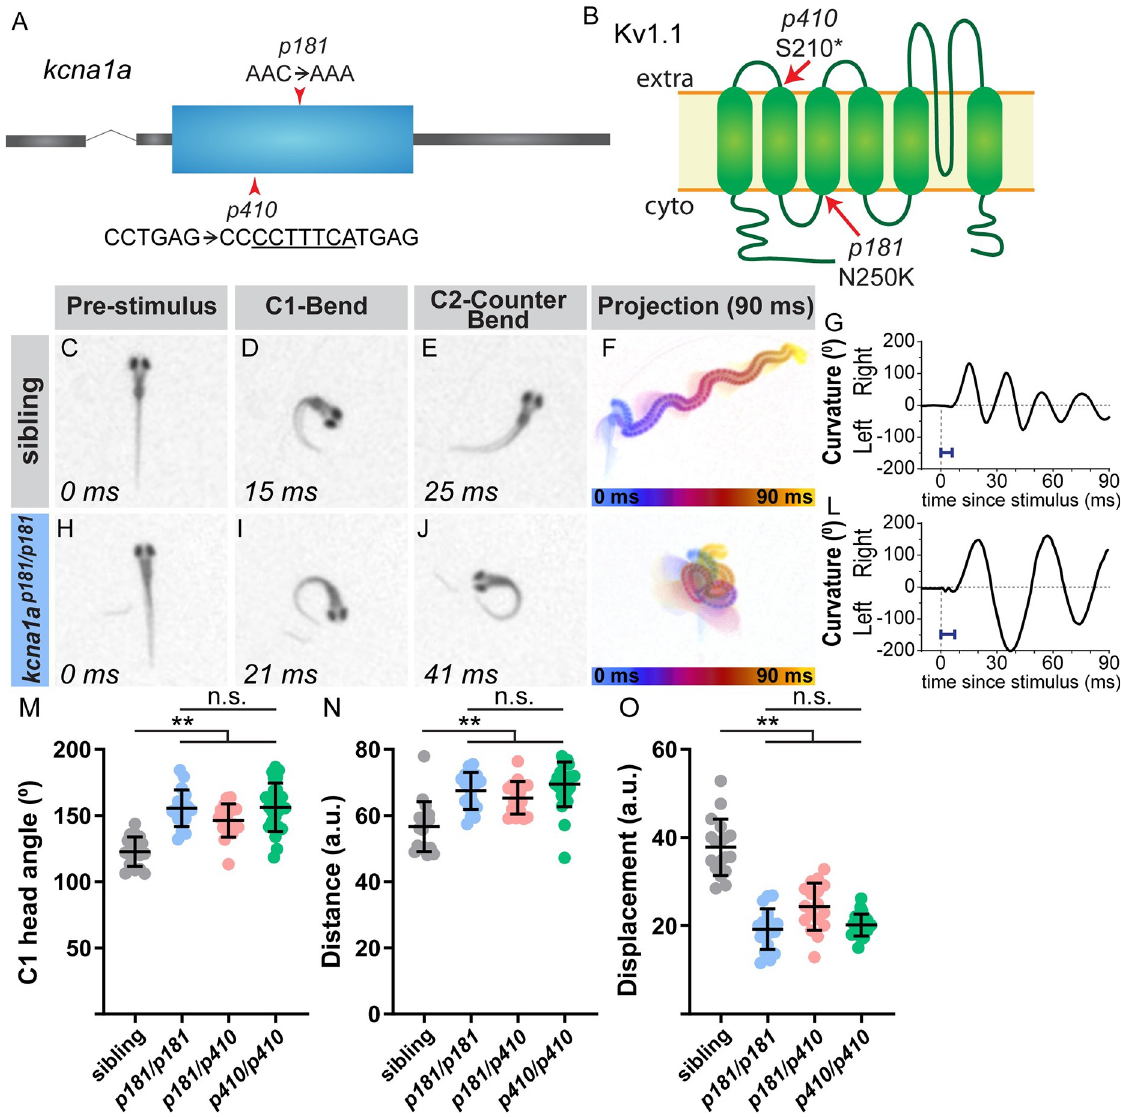
Fig 3. The potassium channel subunit Kv1.1 regulates the magnitude of the startle response. (A) Gene structure for kcna1a with the missense mutation from the screen noted ( p181 ). The CRISPR 7 bp insertion allele is also noted ( p410 ). (B) Protein structure for Kv1.1, which is encoded by kcna1a , on the plasma membrane, with the predicted amino acid change from the screen allele ( p181 ) indicated. The insertion in the CRISPR allele ( p410 ) causes a frame shift in the sequence that results in a premature stop at amino acid 210. In contrast to siblings (C-G), kcna1a mutants (H-L) display an exaggerated startle response, with an increased bend and counter bend angle (I,J), resulting in fish swimming in a “figure eight” (K). Blue bar = latency in G,L. (M-O) Kinematic parameters of the acoustic startle response in kcna1a sibling and mutants (homozygotes of the screen mutation, p181/p181 , transheterozygotes of the screen mutation and CRISPR, p181/p410 , and homozygotes of the CRISPR mutation, p410/p410 ). Each point represents average of ten trials for an individual fish. n � 17 larvae, �� p < 0.001 (one-way ANOVA with Tukey correction for multiple